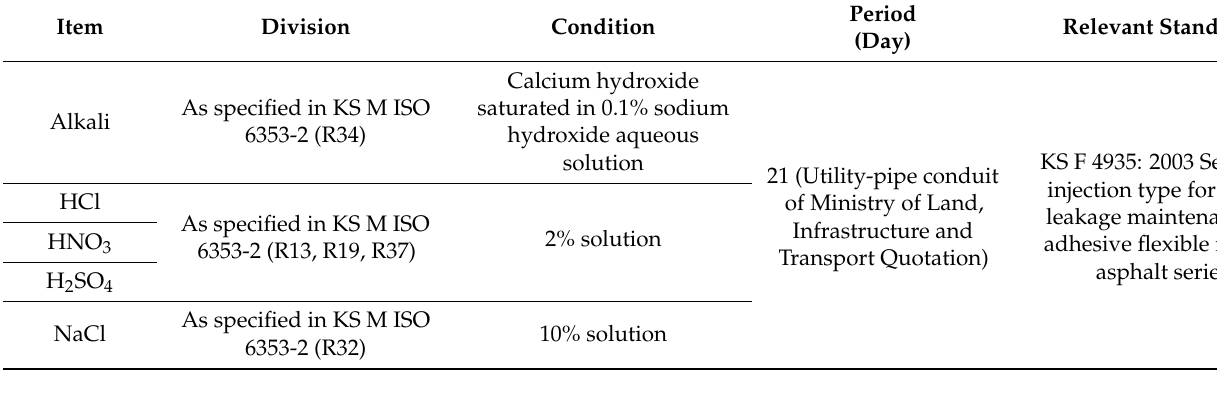
Table 9. Specimen deterioration treatment method.